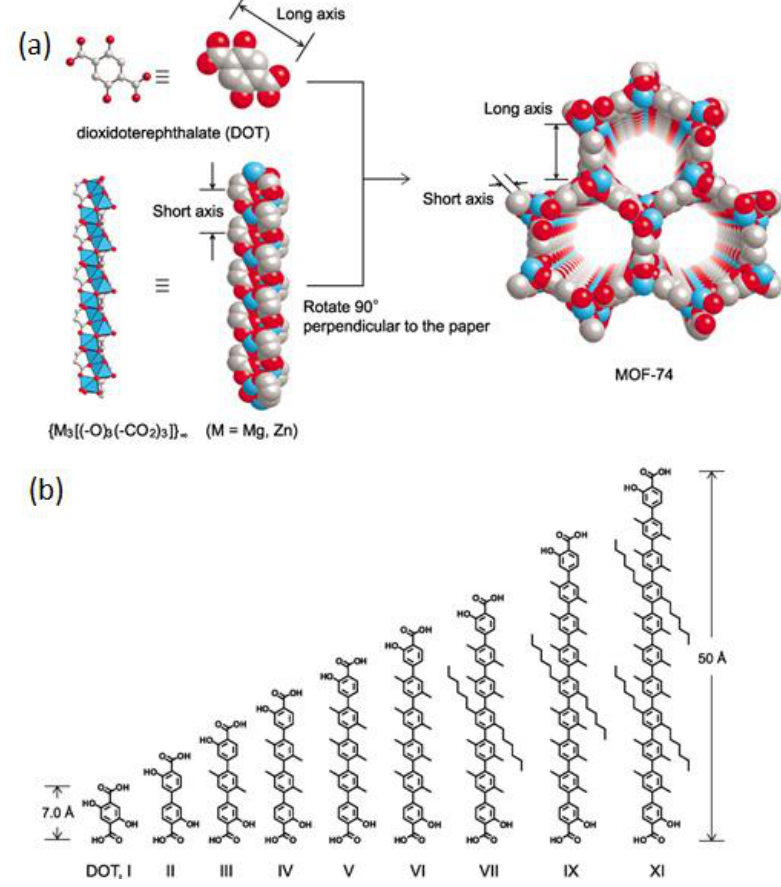
Figure 3. Structure (a) and linkers (b) of IR-MOF-74 family [140]. Adapted from ref. 142 with per- mission.